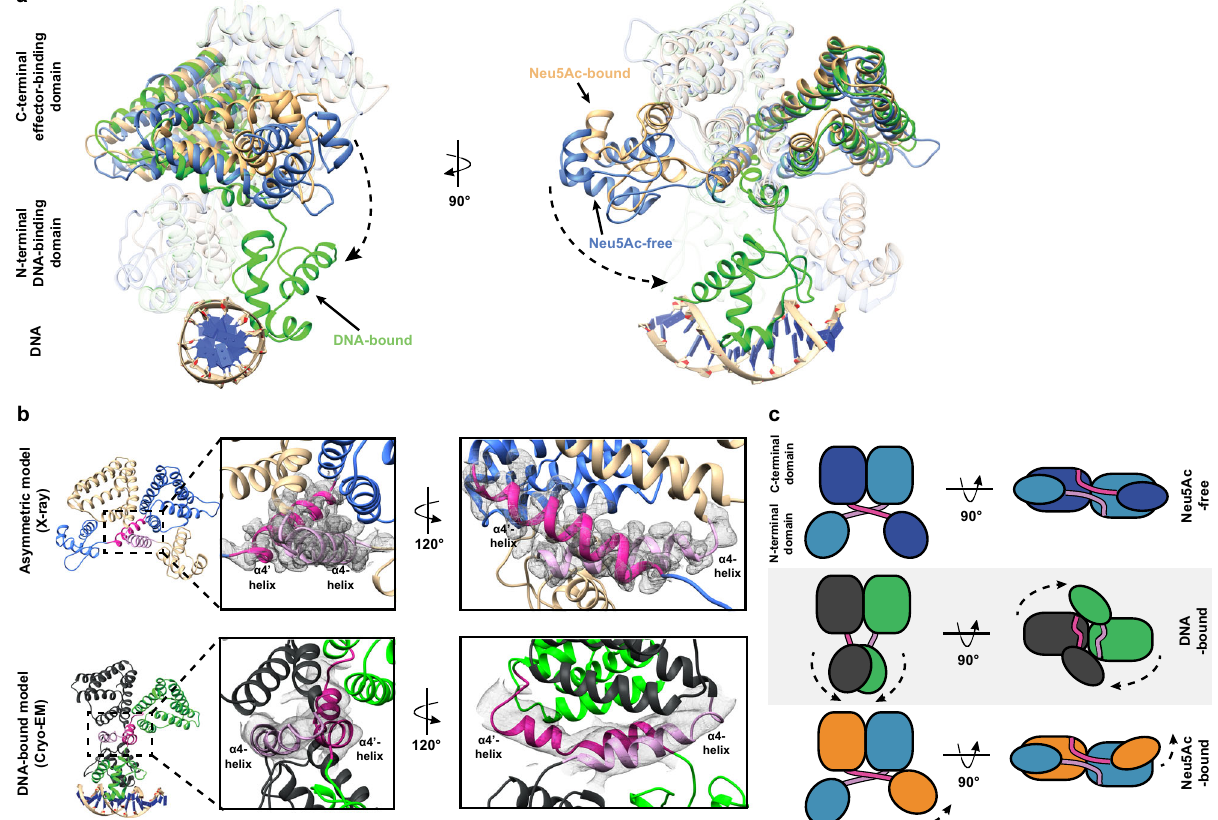
Fig. 6 NanR undergoes large conformational changes on DNA binding. a The three structural states of E. coli NanR (Neu5Ac-free (cyan), Neu5Ac-bound (beige), and DNA-bound (green)) are superimposed to highlight the conformational changes that occur as part of the allosteric mechanism. Notably, the N-terminal DNA-binding domain is reoriented via the fl exible α 4-helices (dash arrows). b The electron density between models shows that the α 4-helices (light and dark pink) mediate a domain-swapped interface in the crystal structure (upper panel); however, these are no longer domain swapped when bound to DNA (lower panel). c Schematic to illustrate the structural changes the domains undergo between each